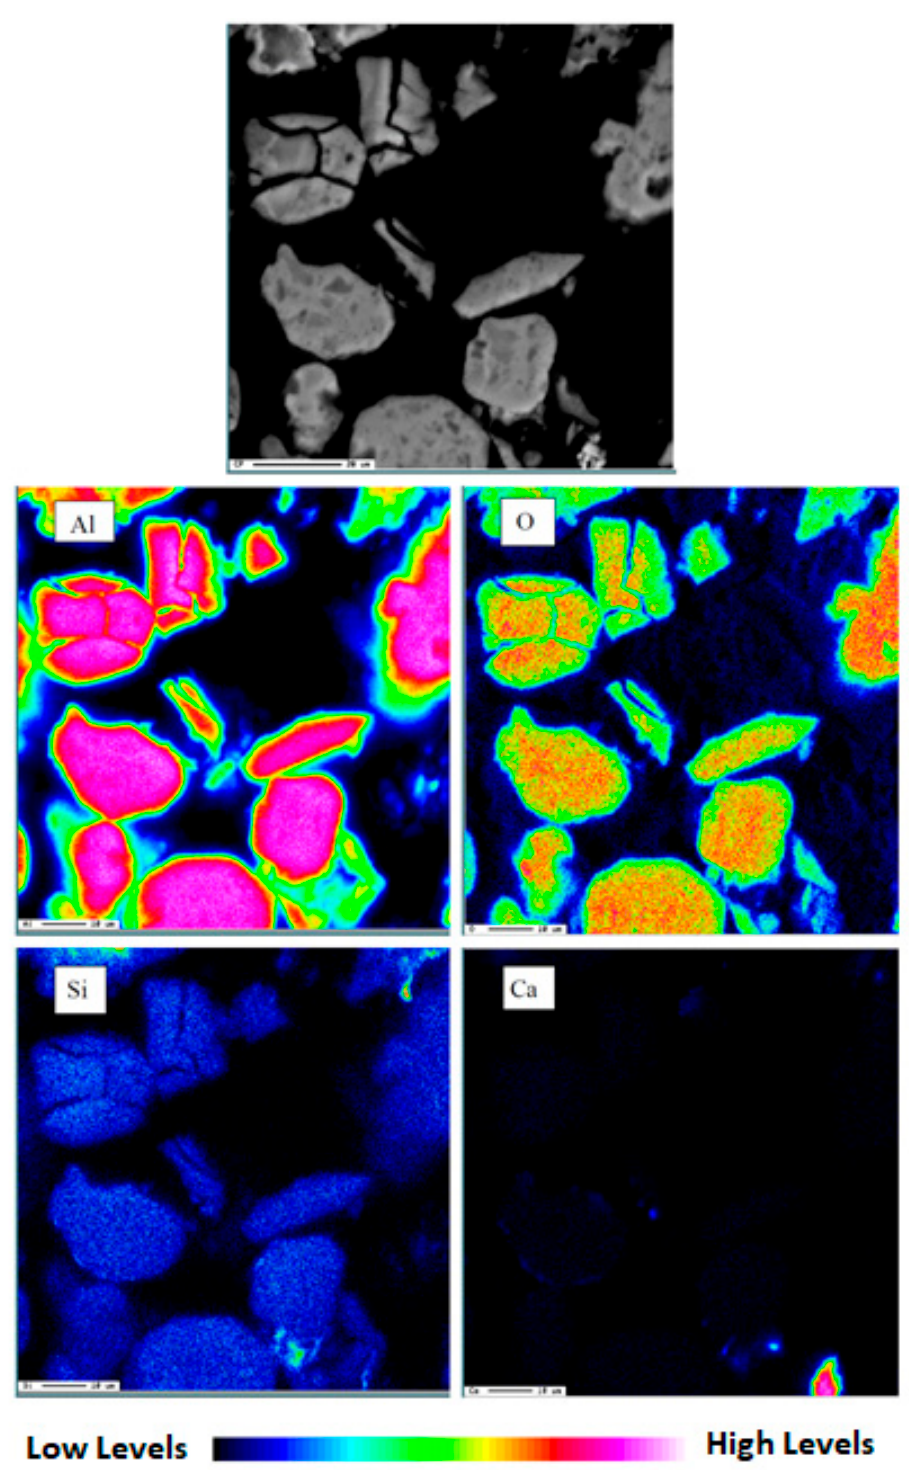
Figure 14. Elemental mapping of used γ -Al 2 O 3 (initial pH 8.5, 5 g/L, 35 ◦